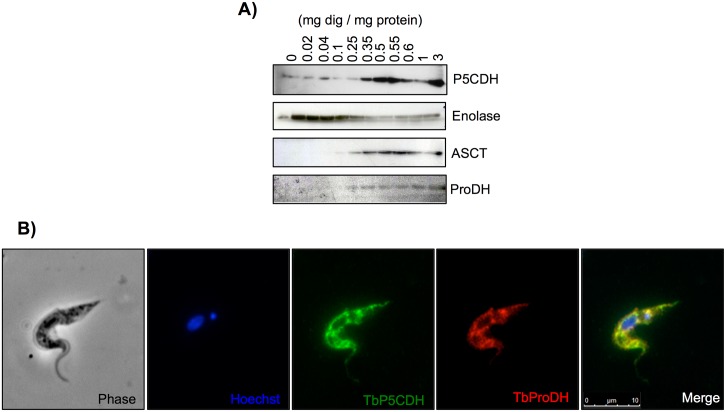
Subcellular localization of TbP5CDH in PCFs.A) Western blot analysis from protein samples obtained after digitonin fractionation. Detection of TbP5CDH in soluble fractions was compared to protein markers. Specific antibodies against trypanosome enolase, acetate:succinyl-CoA transferase (TbASCT) and proline dehydrogenase (TbProDH) were used as cytosolic, mitochondrial (matrix) and mitochondrial-inner membrane markers, respectively. B) Immunolocalization profile of TbP5CDH and TbProDH in PCFs. Cells were visualized under phase contrast. DNA was stained with Hoechst probe (Blue). TbP5CDH (green) and TbProDH (red) were labeled using antibodies produced in mouse and rabbit, respectively.